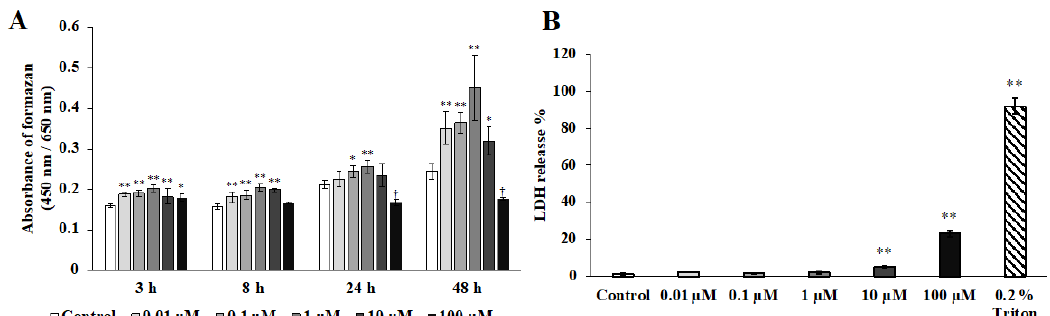
Figure 1. The effect of shikonin on human gingival fibroblast cell proliferation and the cytotoxicity of shikonin. Following cell adherence, the medium was replaced with culture medium, including 10% FBS without (control) or with shikonin (0.01, 0.1 1, 10, or 100 μM). ( A ) Cell proliferation was determined after 3, 8, 24, or 48 h (* p < 0.05 at 3, 8, 24, and 48 h vs. control; ** p < 0.01 at 3, 8, 24, and 48 h vs. control; † p < 0.01 at 3, 8, 24, and 48 h vs. control). ( B ) Cytotoxicity was determined after 48 h (** p < 0.01 vs. control), with Triton (0.2%) used as the positive control.